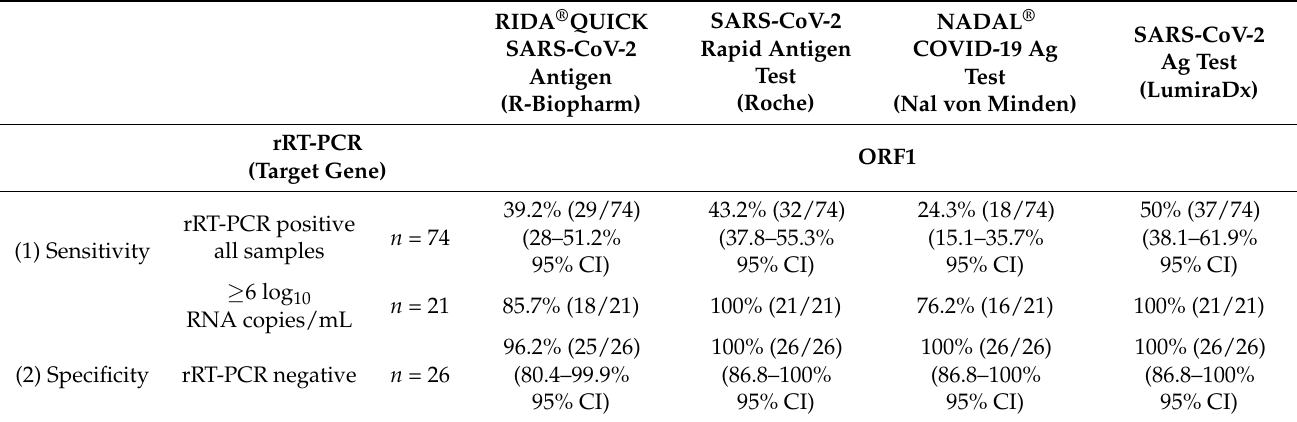
Table 1. Sensitivity and specificity of the examined SARS-CoV-2 Ag-RDTs in comparison to rRT-PCR. (1) Sensitivity % (PCR-positive samples), (2) specificity % (rRT-PCR-negative samples). RIDA ®